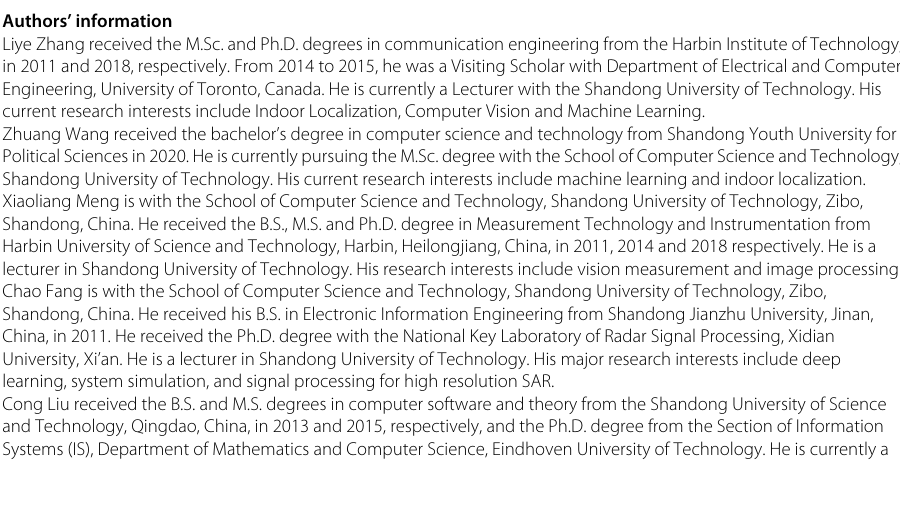
and an smoother radio map is obtained. We tested the proposed method in a typical office environment at Harbin Institute of Technology, and the experimental results demonstrate that the proposed method leads to significantly improvements on localization